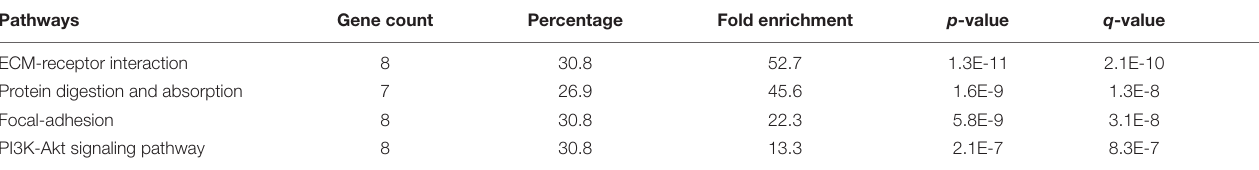
TABLE 2 | KEGG pathways analysis using the DAVID server for top 25 correlated genes of COL11A1 in Colorectal cancer. Pathways Gene count Percentage Fold enrichment p -value q -value ECM-receptor interaction 8 Protein digestion and